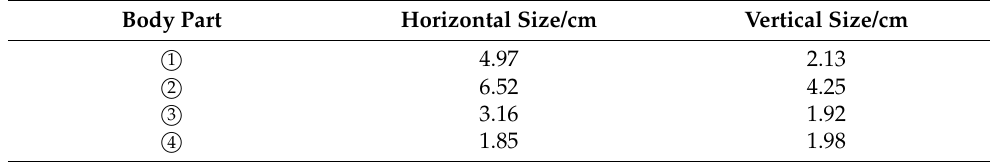
Table 4. The predicted and finished sizes of the sensors in different body parts.